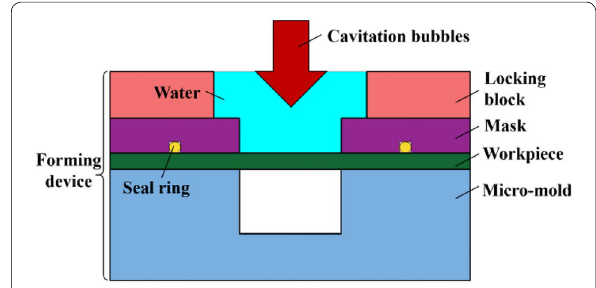
Figure 4 Schematic illustration of forming device